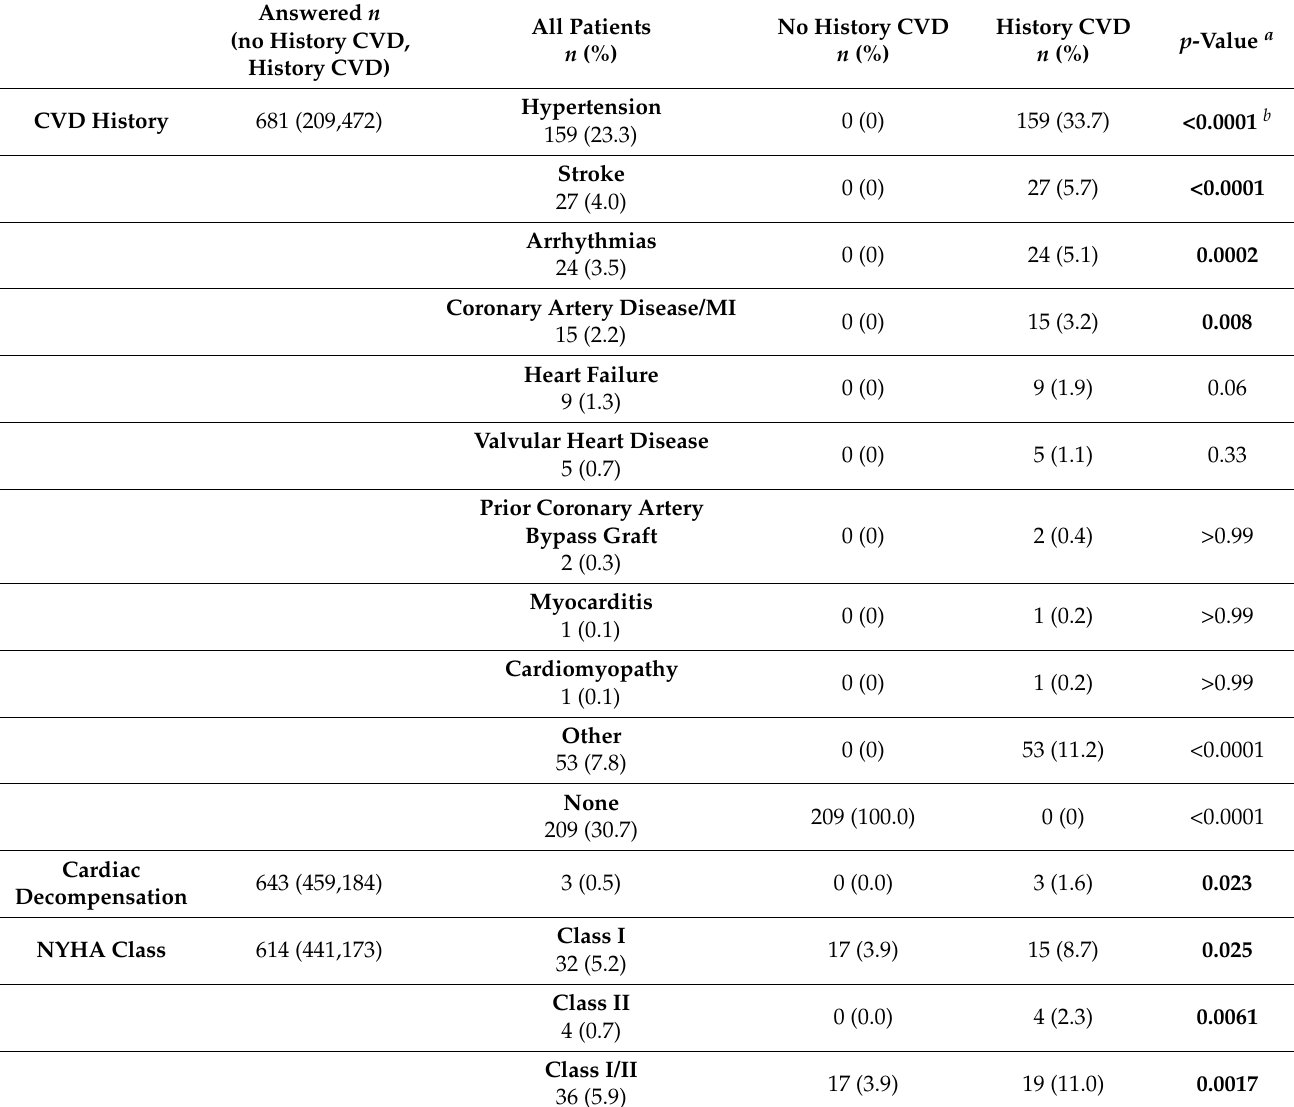
Table 6. Cardiovascular findings in registry patients with or without a history of